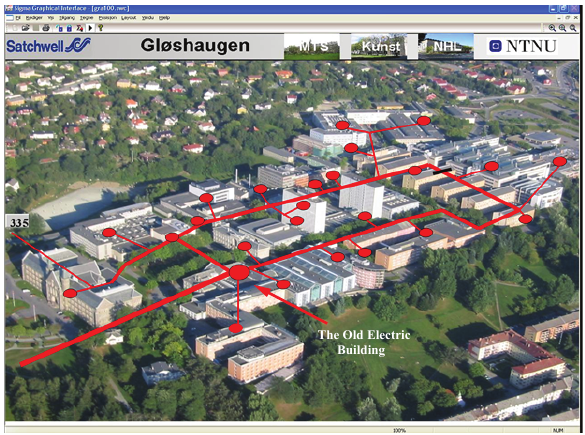
Figure 2: University campus